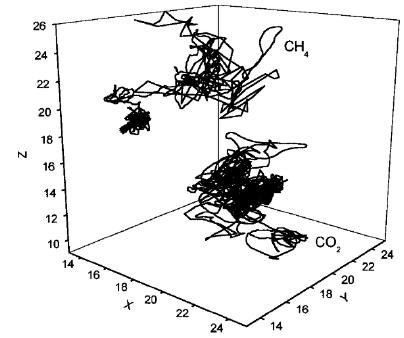
Figure 23. The local trajectories of CH 4 and CO 2 in the polyetherimide [89]. The mean square displacement (MSD) of gas molecules typically includes collisions inside the free volume and the jump between the adjacent free volume holes. As shown in Figure 24, the result of repeated jumps is the diffuse motion of the gas molecule